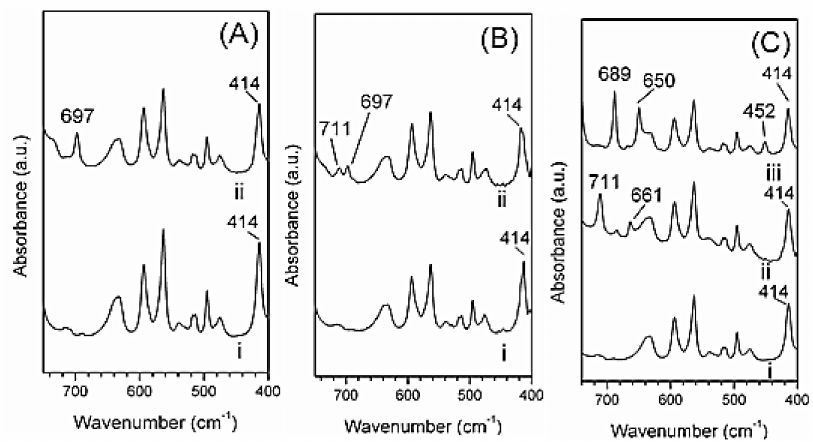
Figure 8. ( A ) FTIR spectra of PPO aerogels before (curve i) and after (curve ii) immersion in a 100 ppm aqueous solution of benzyl alcohol; ( B ) FTIR spectra of PPO 0.8 / r-GO 0.2 aerogels before (curve i) and after (curve ii) immersion for 4 days in a 100 ppm benzyl alcohol solution; ( C ) FTIR spectra of PPO aerogels before (curve i) and after immersion in a 100 ppm solution of benzoic acid (curve ii) and benzaldehyde (curve